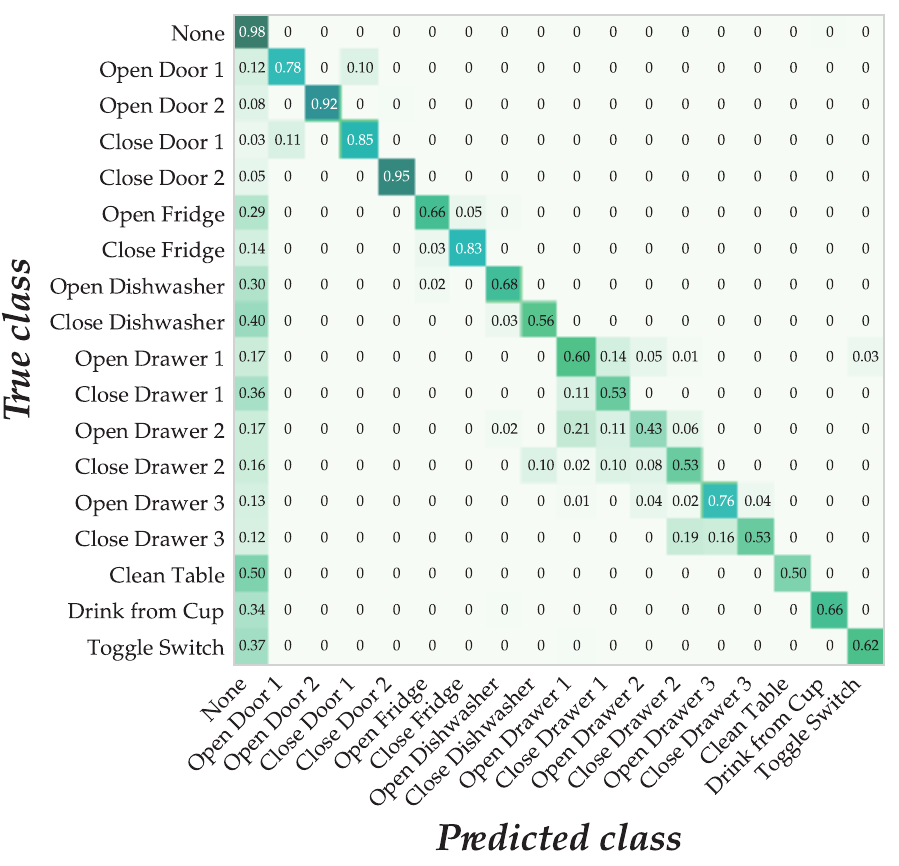
Figure 7. Confusion matrix of the best ensemble using GE individuals with